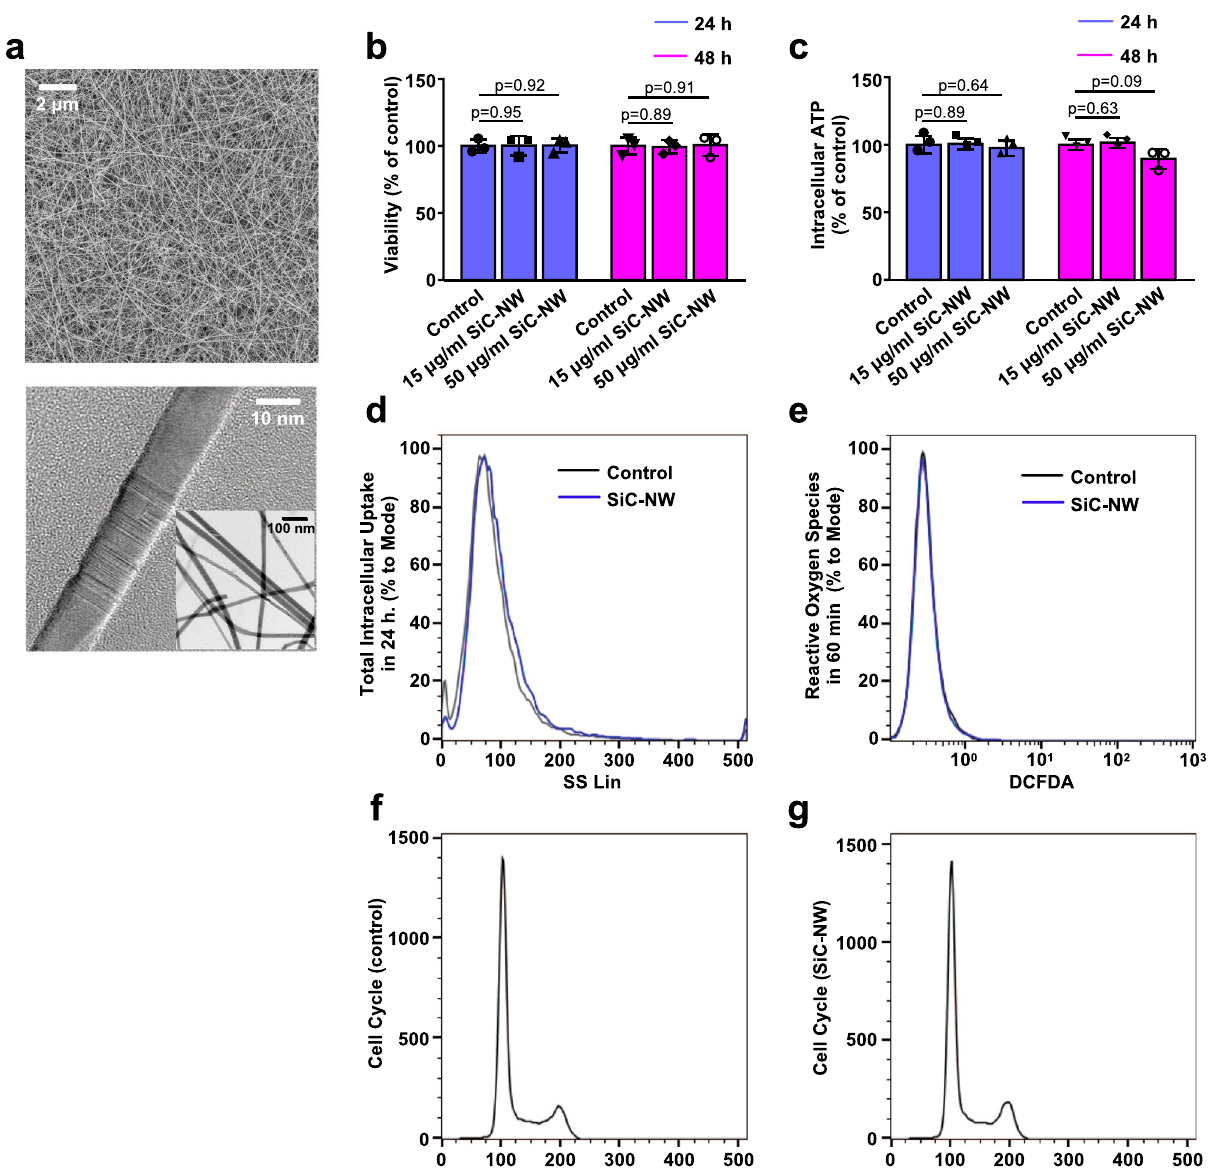
Fig. 1 Growth of silicon carbide nanowires (SiC-NWs): physicochemical and biocompatibility characterizations. a Representative bright- fi eld SEM (top) and TEM (bottom) images of SiC-NWs detached from the substrate ( n = 50 experiments repeated with similar results). b Viability of HL1 cardiomyocytes at 24 h (blue) and 48 h (pink) in control (no SiC-NWs) and SiC-NWs conditions ( n = 3 biologically independent experiments in each group). Data are represented as mean ± SD. Unpaired two-sided Student ’ s t -test (statistical signi fi cance set at p < 0.05). Source data are provided as a Source Data fi le. c Same as b for intracellular ATP concentration. d Total intracellular uptake of SiC-NWs by HL1 cells ( n = 3 experiments repeated with similar results). SS Lin Side scatter on a linear scale. e 60 min of reactive oxygen species (ROS) production from HL1 cells cultured w or w/o 50 µ g/ml of SiC-NWs ( n = 3 experiments repeated with similar results). DCFDA dichlorodihydro fl uorescein diacetate. f Cell cycle characteristics of control (no SiC-NWs) HL1 cells ( n = 3 experiments repeated with similar results). PI propidium iodide. g Same as f after 48 h of exposure to 50 µ g/ml